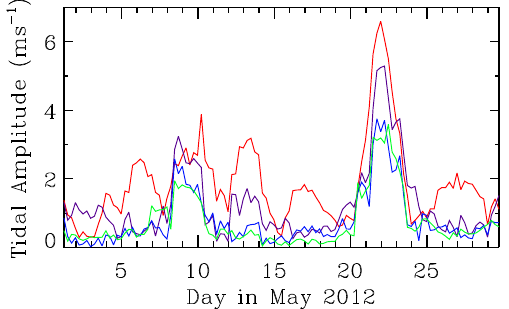
Figure 7. Amplitude variations in the four tidal components DT (red), ST (purple), TT (blue), and QT (green).